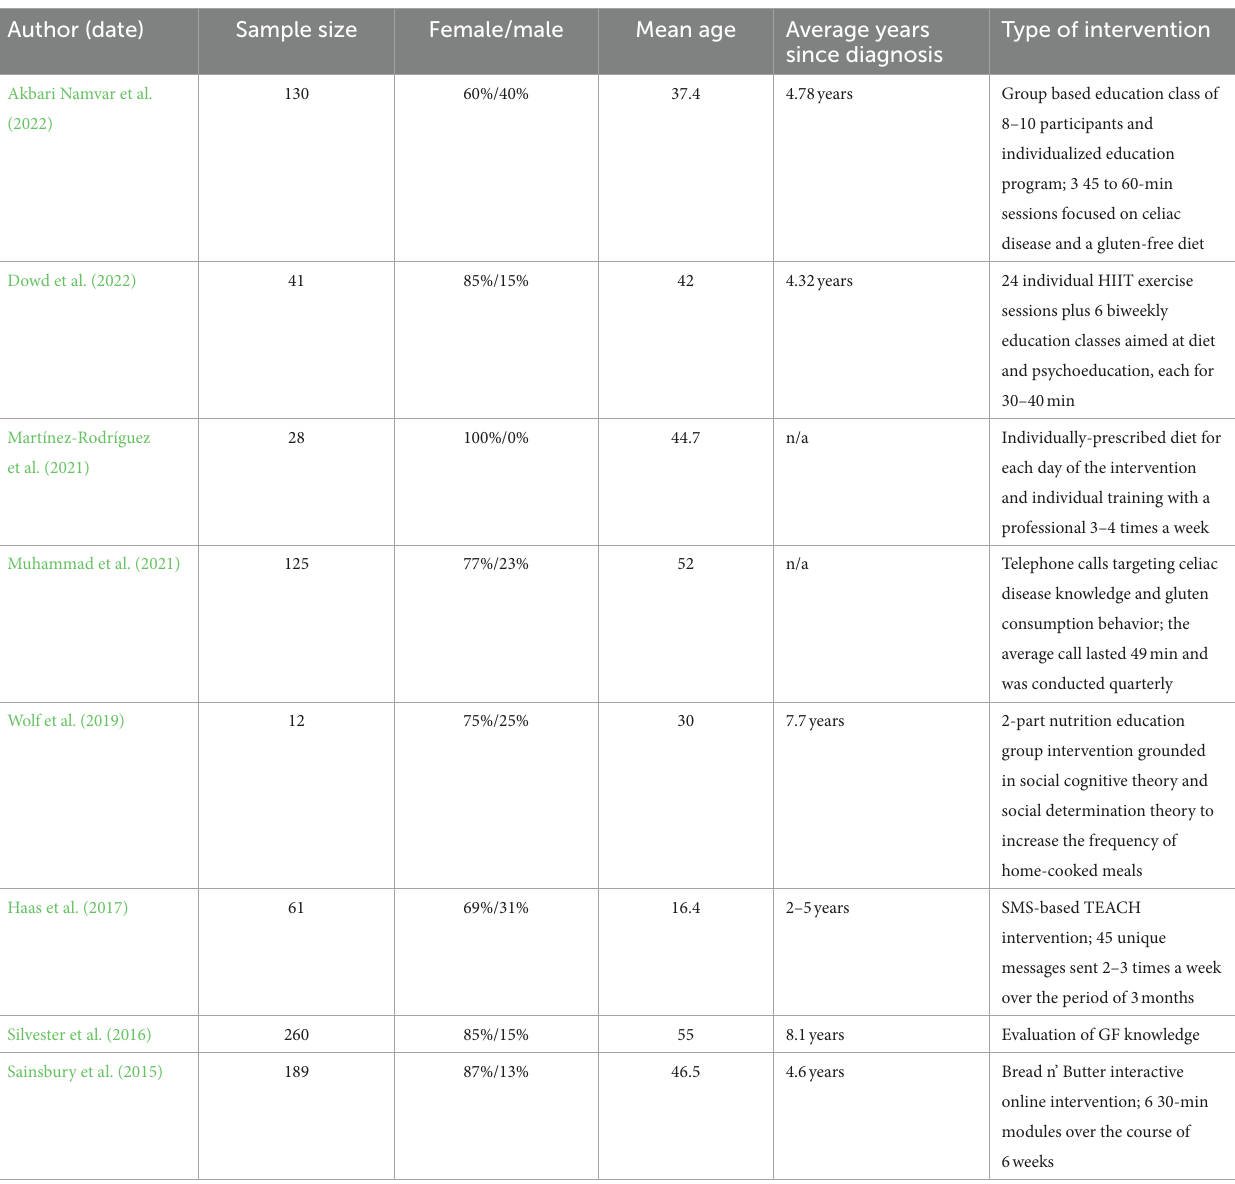
TABLE 3 Summary of demographics and characteristics of the